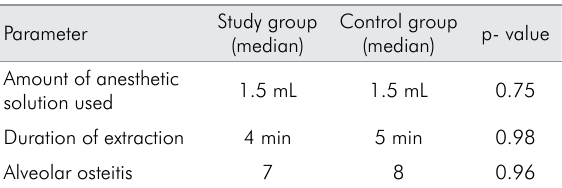
Table. Parameters evaluated in the study, median values and